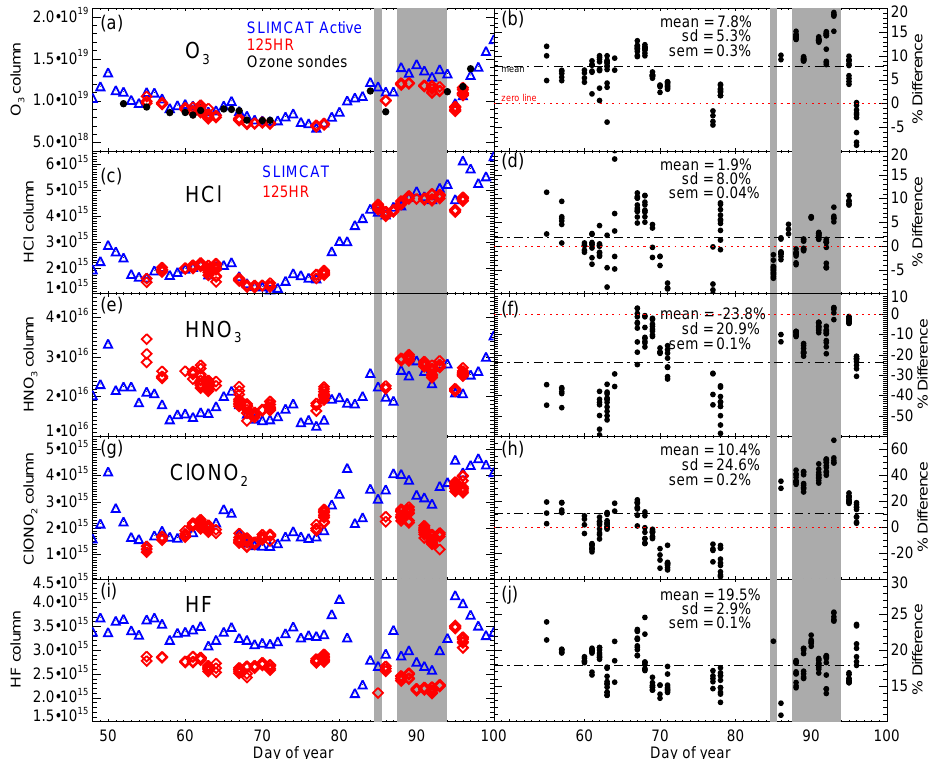
Fig. 7. 125HR (red diamonds) and SLIMCAT (blue triangles) total column comparisons for ozone, HCl, HNO 3 , ClONO 2 , and HF. For ozone, the Eureka ozonesonde measurements (black circles) are also superimposed. In the panels on the left side, the total columns for each gas are shown for the measurements and the model, while in the panels on the right side the corresponding percentage differences are shown. The mean percentage difference, the standard deviation, and the standard error of the mean are also given. These were calculated as described in the text. The gray shading has the same meaning as in Fig.